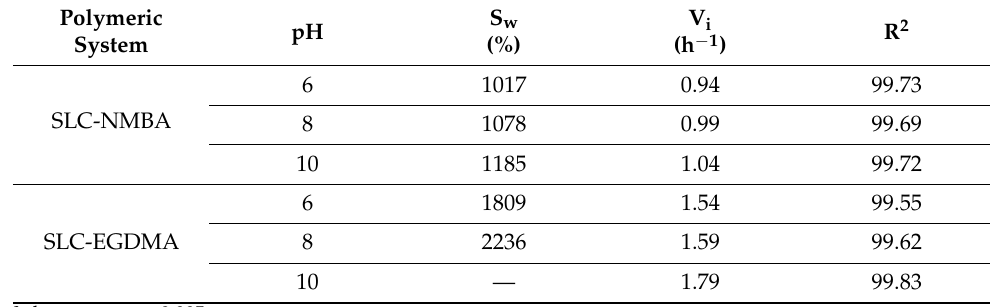
Figure 5. Swelling kinetic curves for SLC systems at pH 6, 8, and 10. Table 3. Swelling percentages at 48 h and linear initial swelling velocity at different pHs a .